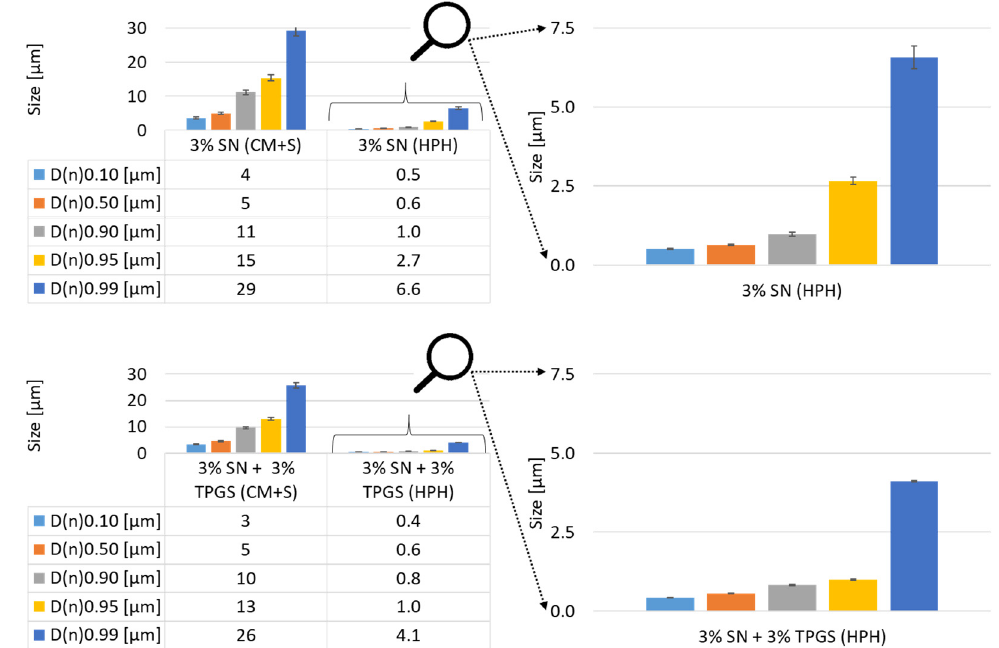
Figure 5. Numerically based size distribution of unprocessed and processed SN samples. Top, left: Without surfactant. Bottom, left: With surfactant. Right: Rescaled results for the corresponding PlantCrystals samples for better visualization and comparison.